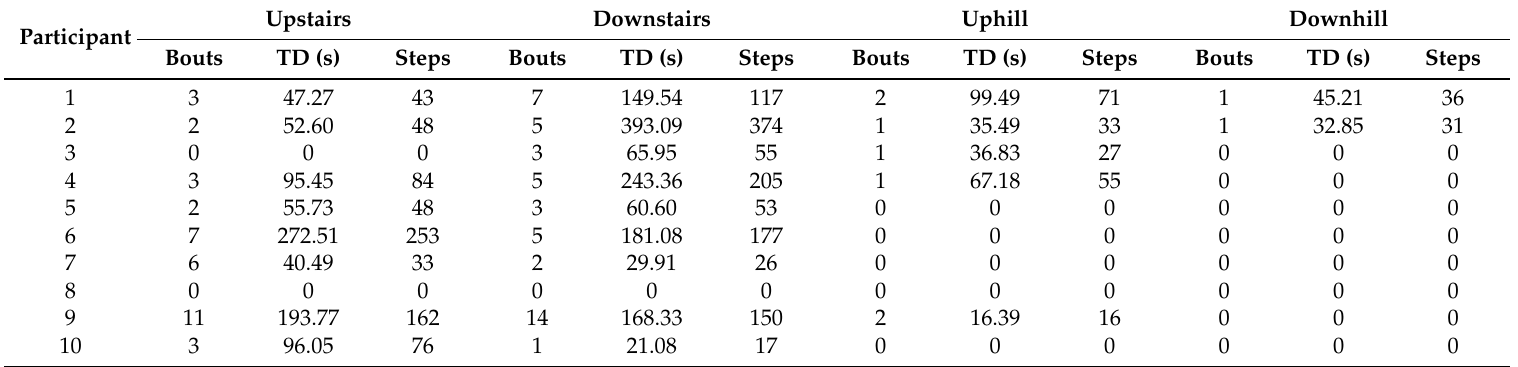
Table 4. Non-level locomotion periods. TD: total duration in